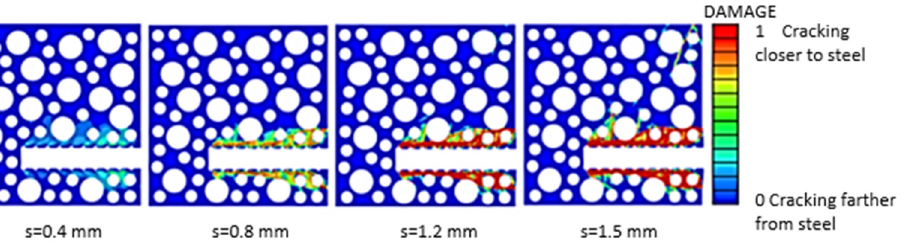
Figure 31. Concrete damage process using mesoscale modelling for di ff erent displacement(s) [63].